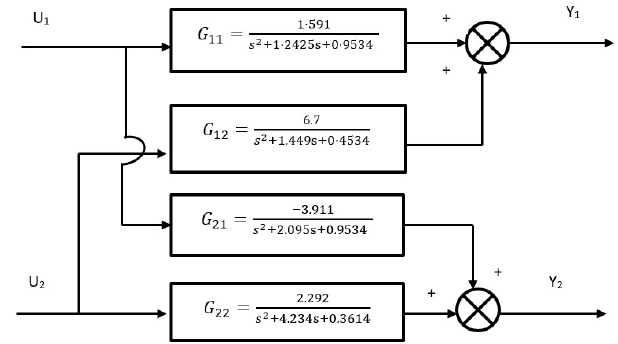
Figure 8. Multiloop Controller Design of a Greenhouse